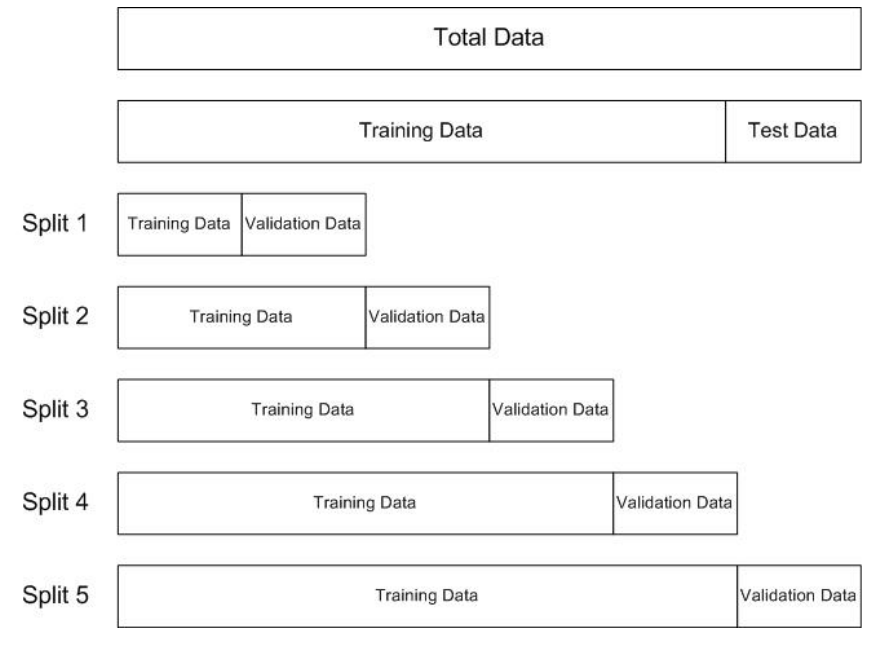
Figure 12. Data splits used for training the model.